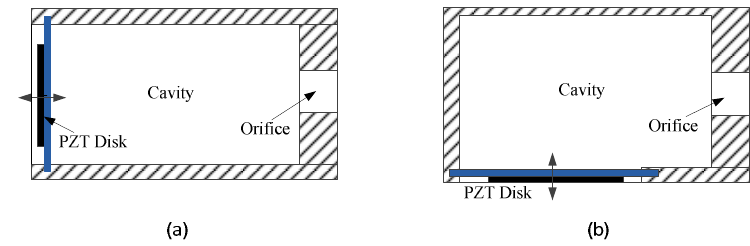
Fig. 1 Schematic of synthetic-jet actuator, (a) bottom mount piezoceramic disk and (b) side mount piezoceramic disk (with respect to the